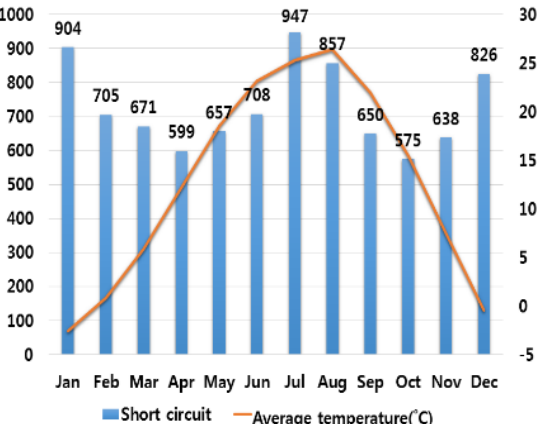
Figure 2. Correlation between the number of fires caused by short circuit and the average temperature on a monthly basis.